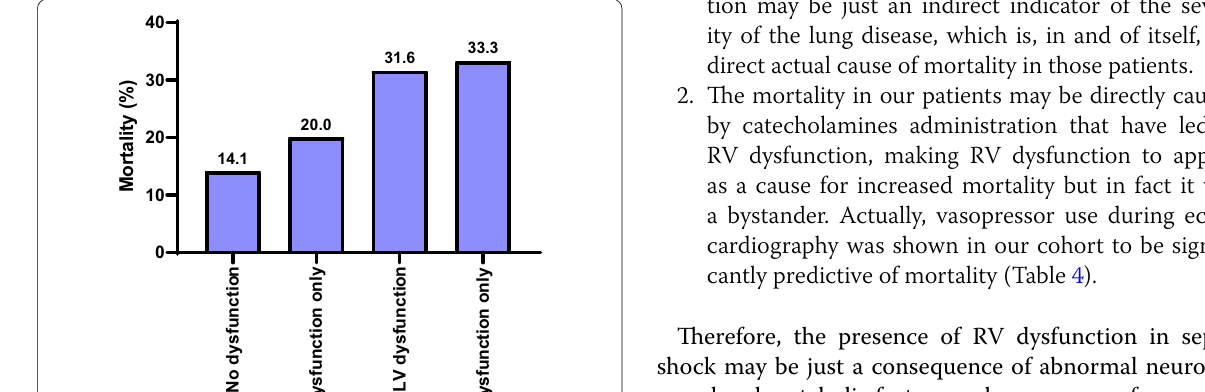
RV, Right ventricular; LV, Left ventricular